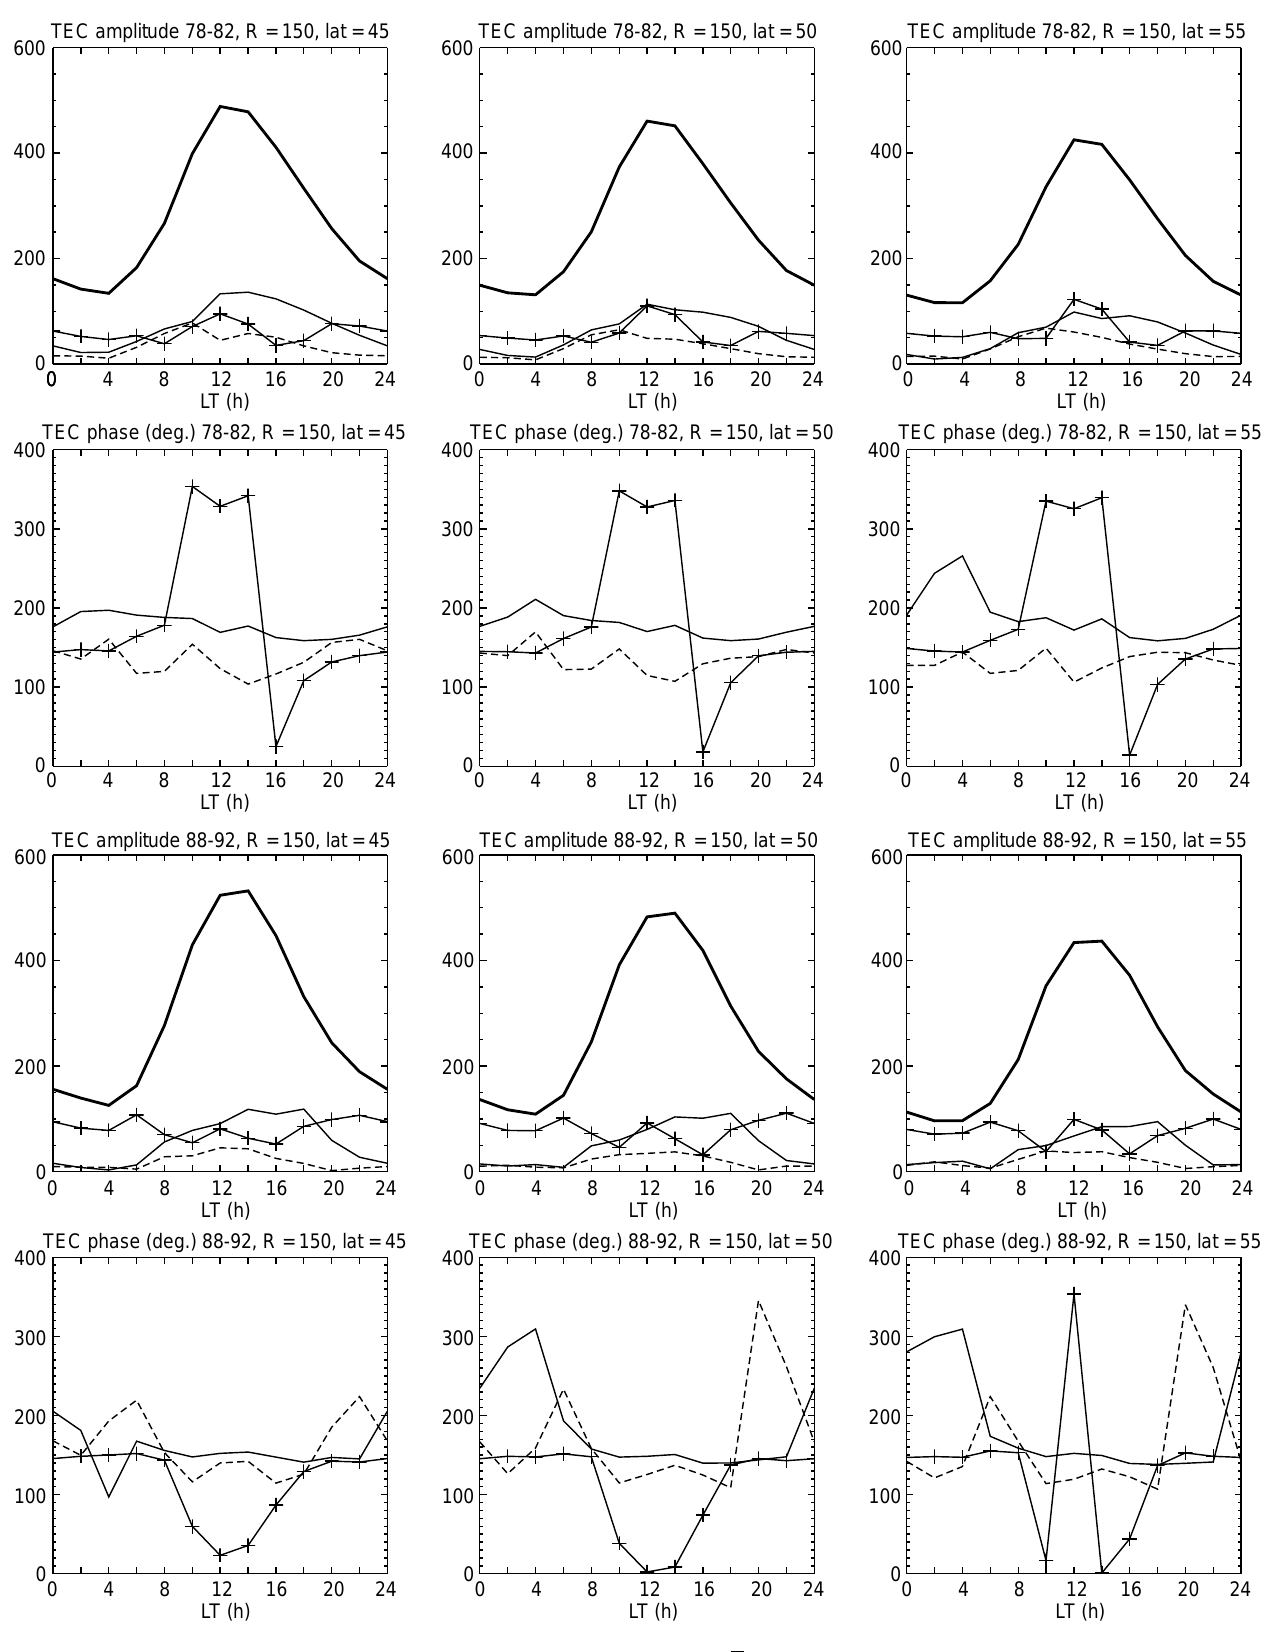
Fig. 2. Diurnal variation of amplitudes (top and third row) and phases (second and bottom row) for Fourier components of the annual variation of ionospheric electron content (TEC): mean ( heavy lines ), 1- year ( crosses ), 1/2 year ( thin line ), 4-months ( dashed line ). High solar